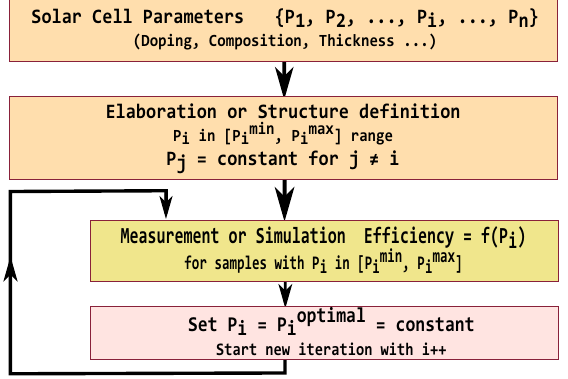
Fig. 1. The parametric